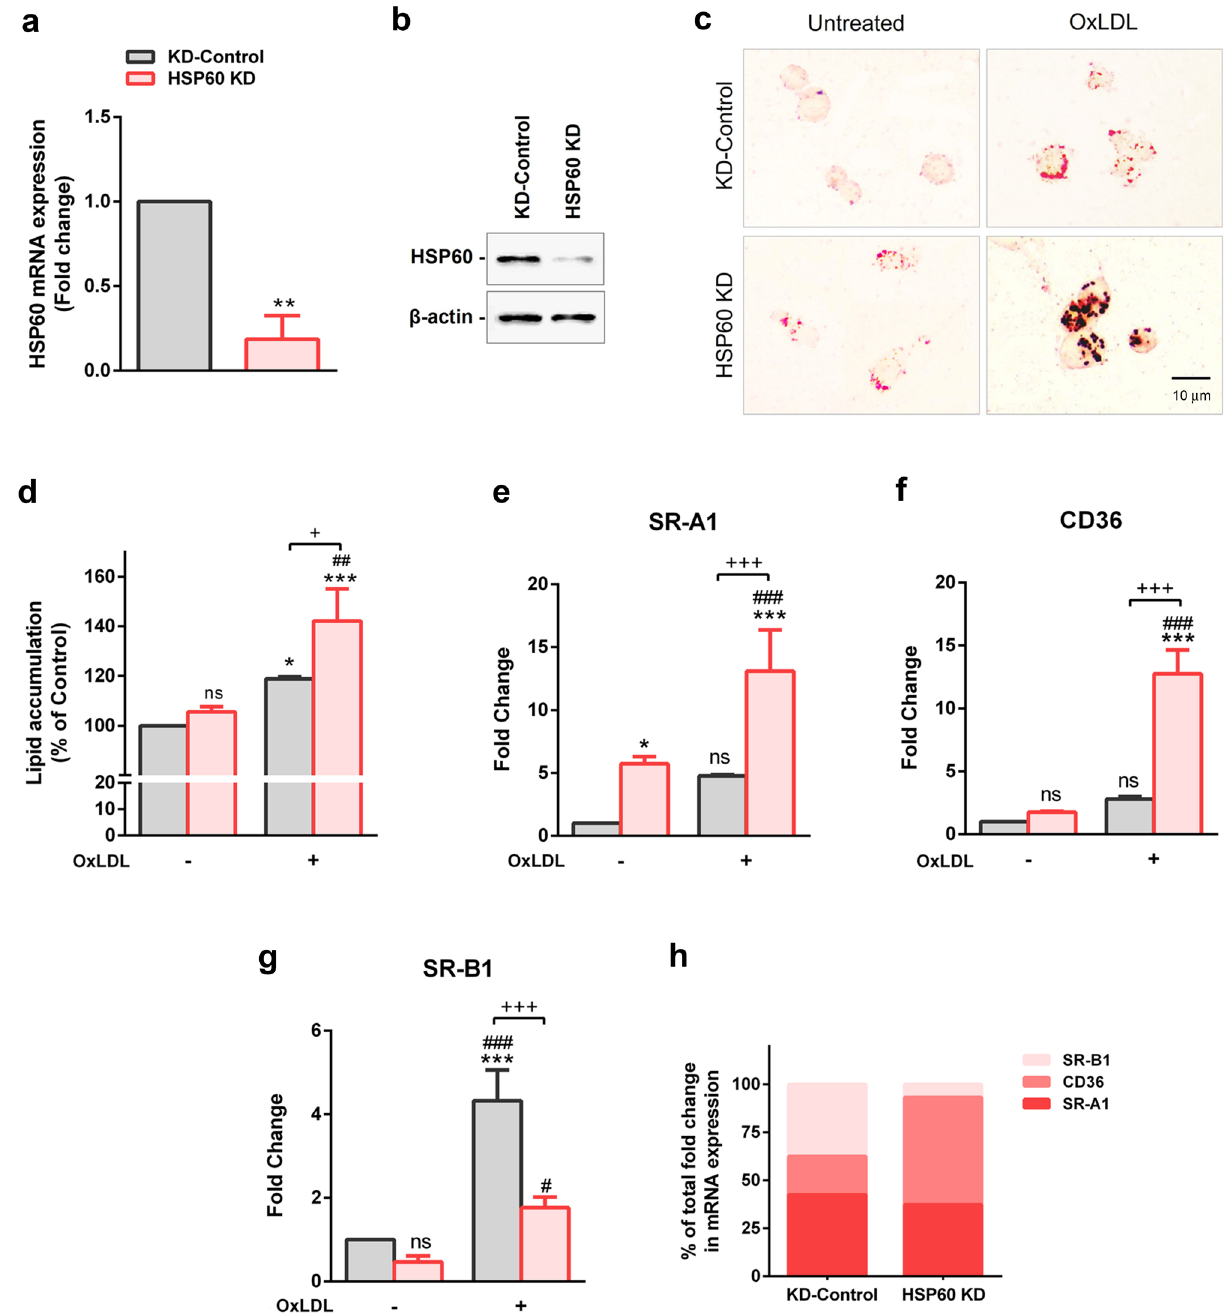
Figure 8. OxLDL uptake and scavenger receptor expression in HSP60 KD TDMs. Knockdown of HSP60 in TDMs was confirmed by ( a ) quantitative RT-PCR and ( b ) western blotting (n = 3). **p < 0.01, vs untreated KD-Control, two-tailed Student’s t-test. TDMs were subjected to ORO staining to check the OxLDL uptake ( c ). Representative images of stained cells (Scale bar = 10 µm) and ( d ) quantitative measurement of OxLDL accumulation. mRNA expression of ( e ) SR-A1, ( f ) CD36 and ( g ) SR-B1 was evaluated by quantitative RT-PCR. ( h ) Comparative analysis of mRNA expression of the three SRs in OxLDL treated KD-Control and HSP60 KD TDMs expressed as percentage of total fold change observed in respective groups. Data were expressed as Mean ± SEM (n = 3). *p < 0.05, ***p < 0.001 vs untreated KD-Control. # p < 0.05, ## p < 0.01, ### p < 0.001 vs untreated HSP60 KD. + p < 0.05, +++ p < 0.001 KD-Control group vs HSP60 KD group, ns non-significant, Two-way ANOVA followed by Tukey’s multiple comparison